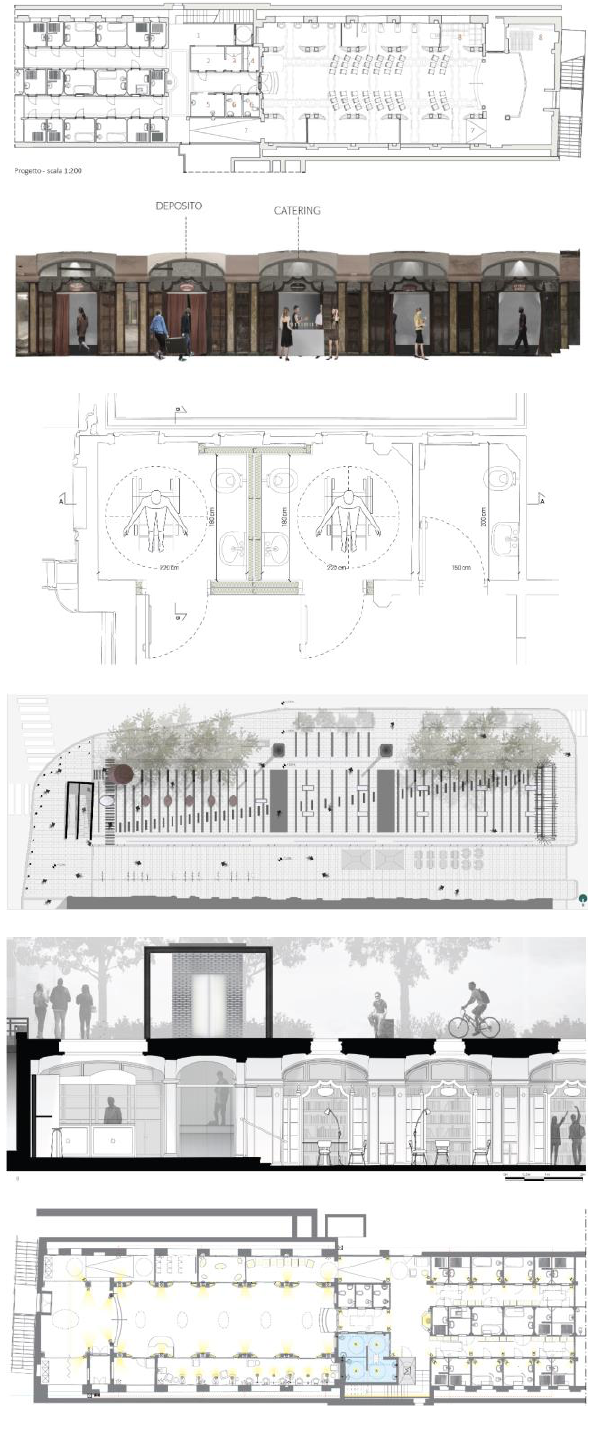
Figure 14. A few images produced by the 6 groups that worked at Diurno. They show the last part of our course: the design